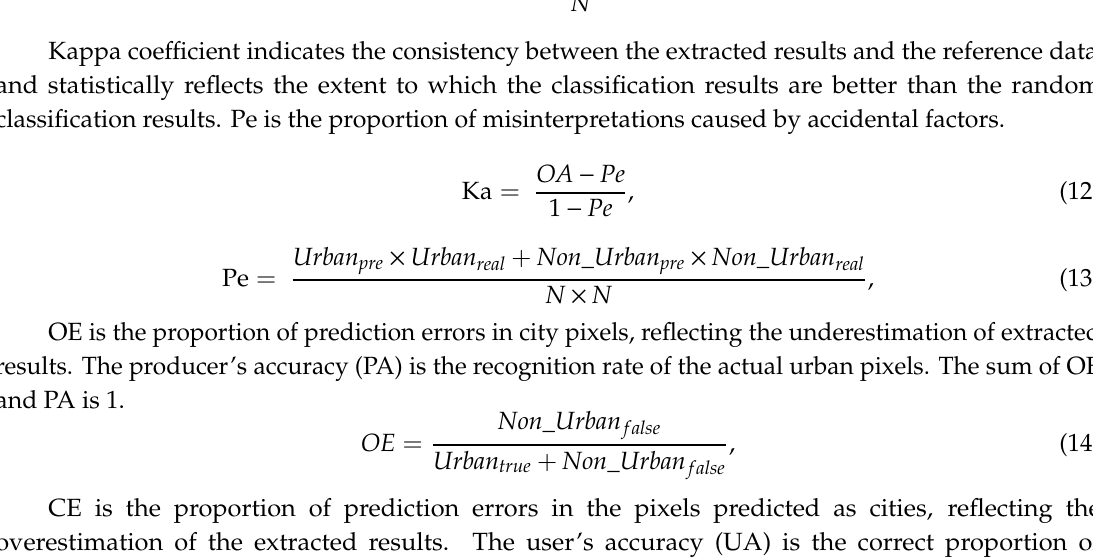
Figure 5. Eight filtering direction templates.